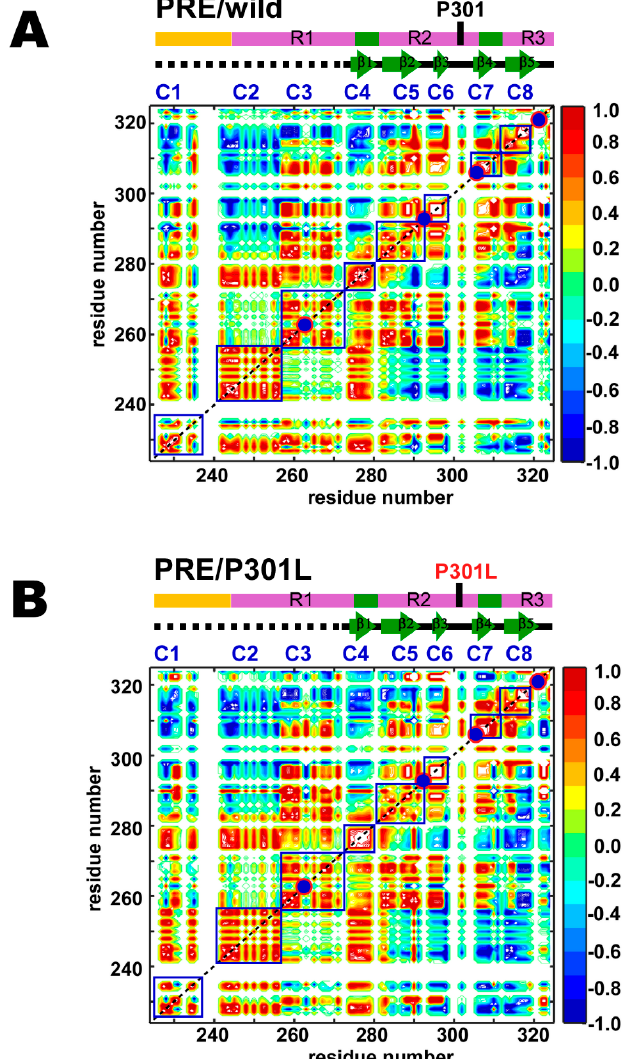
Figure 4. PRE correlation maps for the ( A ) wild-type and ( B ) P301L mutant of TauF4 ∆ . Colors indicate correlated (red), anti-correlated (blue) and uncorrelated (green) contours. Only residue positions with observable PRE rates for two or more mutants are given. MTSL labeling positions are shown on the maps by the red circles filled in dark blue. The segments with locally correlated residues are marked by the blue squares labeled C1–C8.